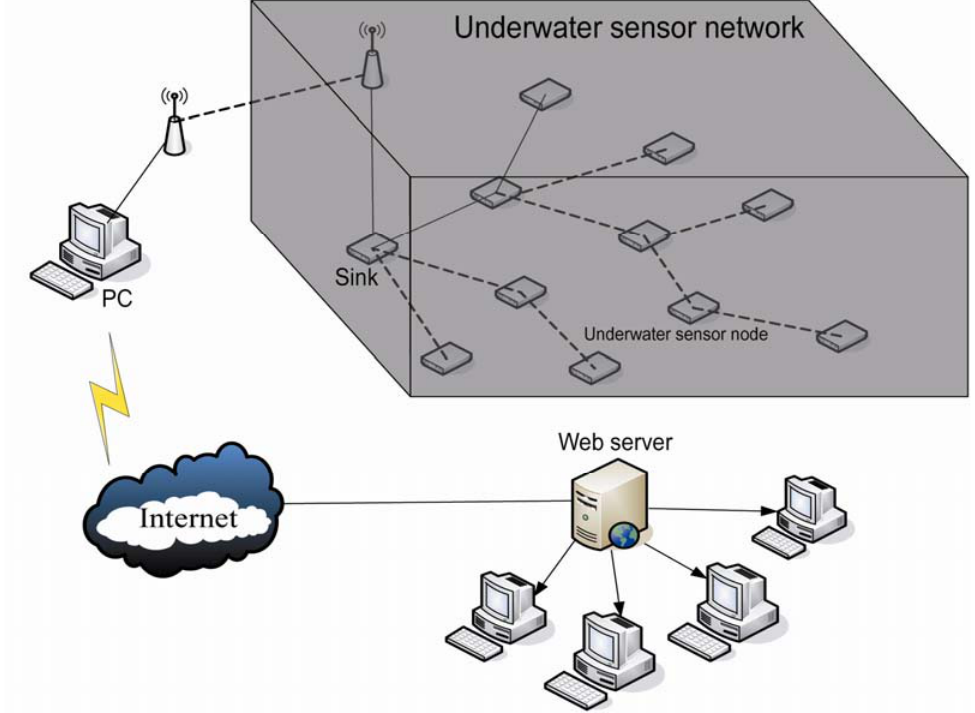
Figure 1. Underwater sensor network